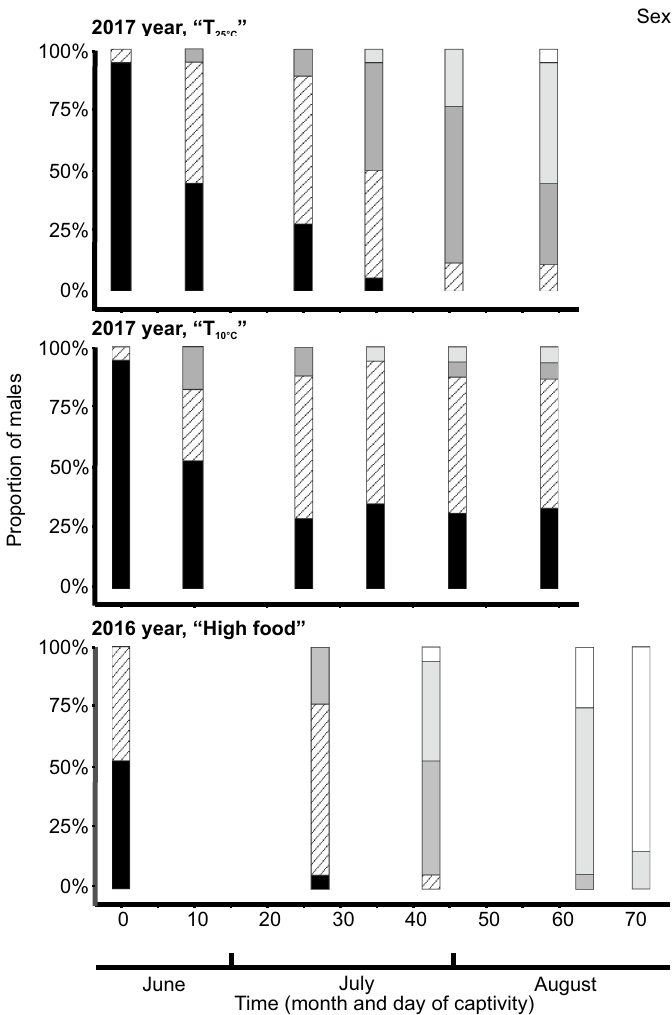
Figure 4. Effect of high and low ambient temperature or food availability on seasonal sexual maturation rate. The proportion of male bats at each sexual maturation classes over the course of the study and under different treatments. Data from the “High food” treatment are from an experiment, where V. murinus males were fed with a large amount of food and exposed to natural ambient temperature 26 . Both experiments started on the same calendar days and the numbering of experimental days is the same in both